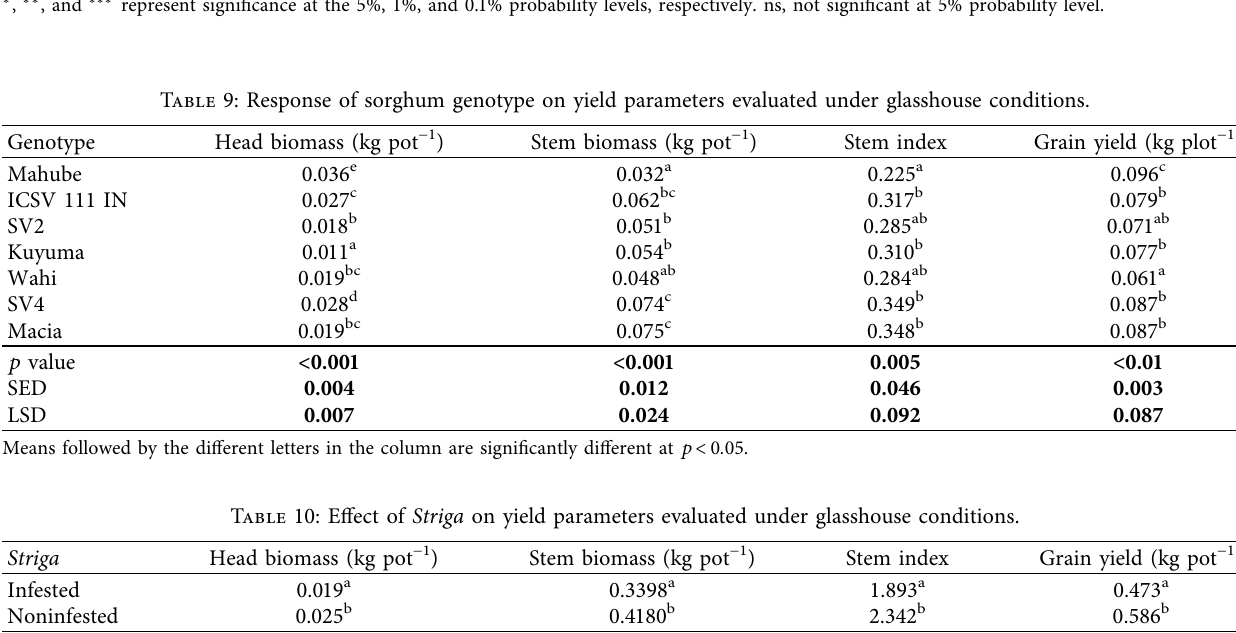
Table 8: Mean square values for sorghum genotypes yield parameters recorded under glasshouse conditions at the University of Zimbabwe. Source Block Genotype ∗ Striga 0.066ns